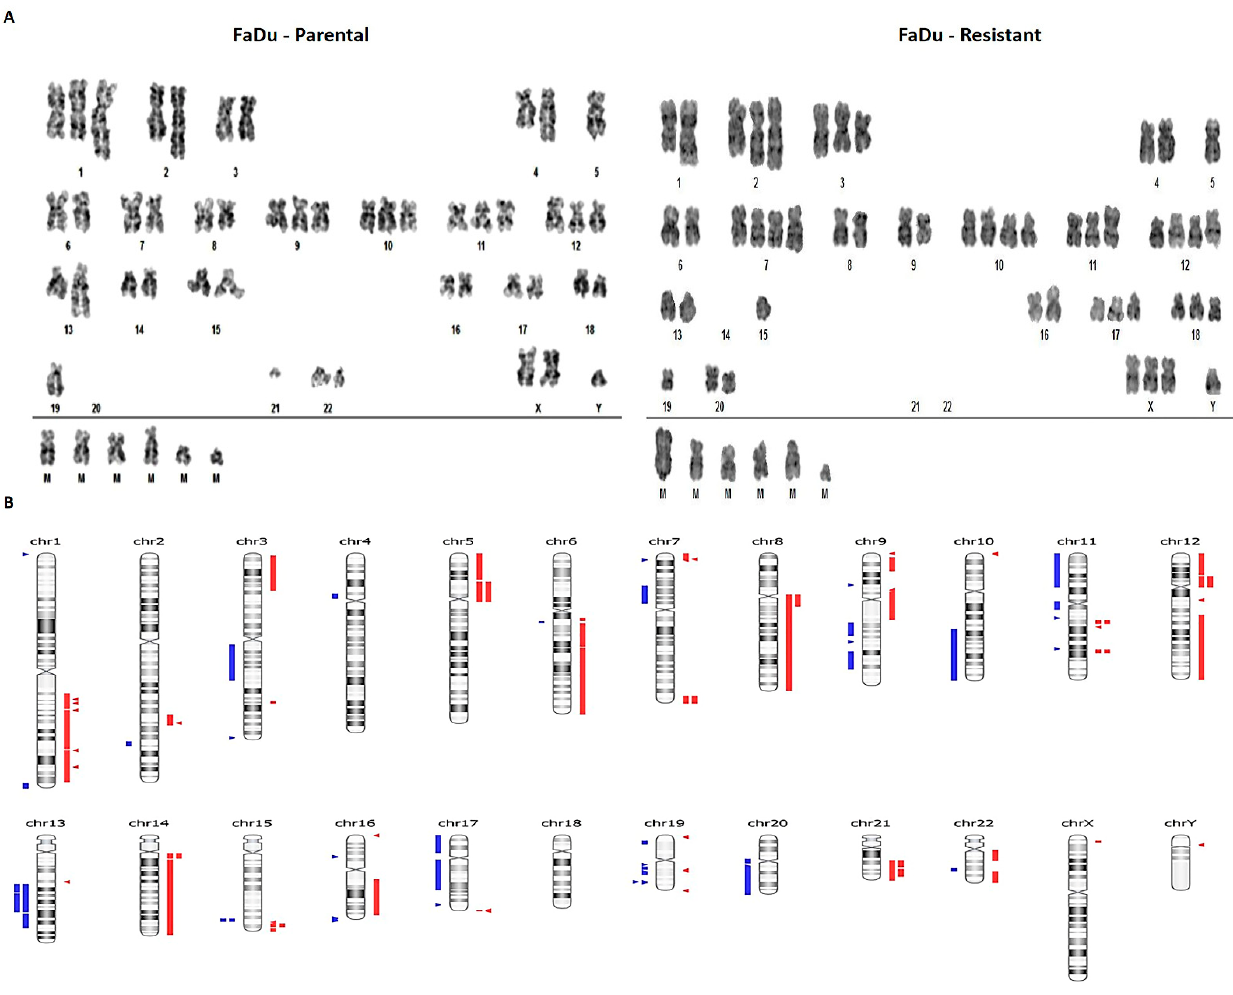
Figure 2. Karyotypes and Copy number alterations (CNA) overview of FaDu parental and FaDu resistant cells. ( A ) Representative metaphase of FaDu parental and FaDu resistant cells. ( B ) Overview of the CNAs found in FaDu resistant cells in comparison with FaDu parental cells. In red gain and in blue deletions. M: marker chromosome.